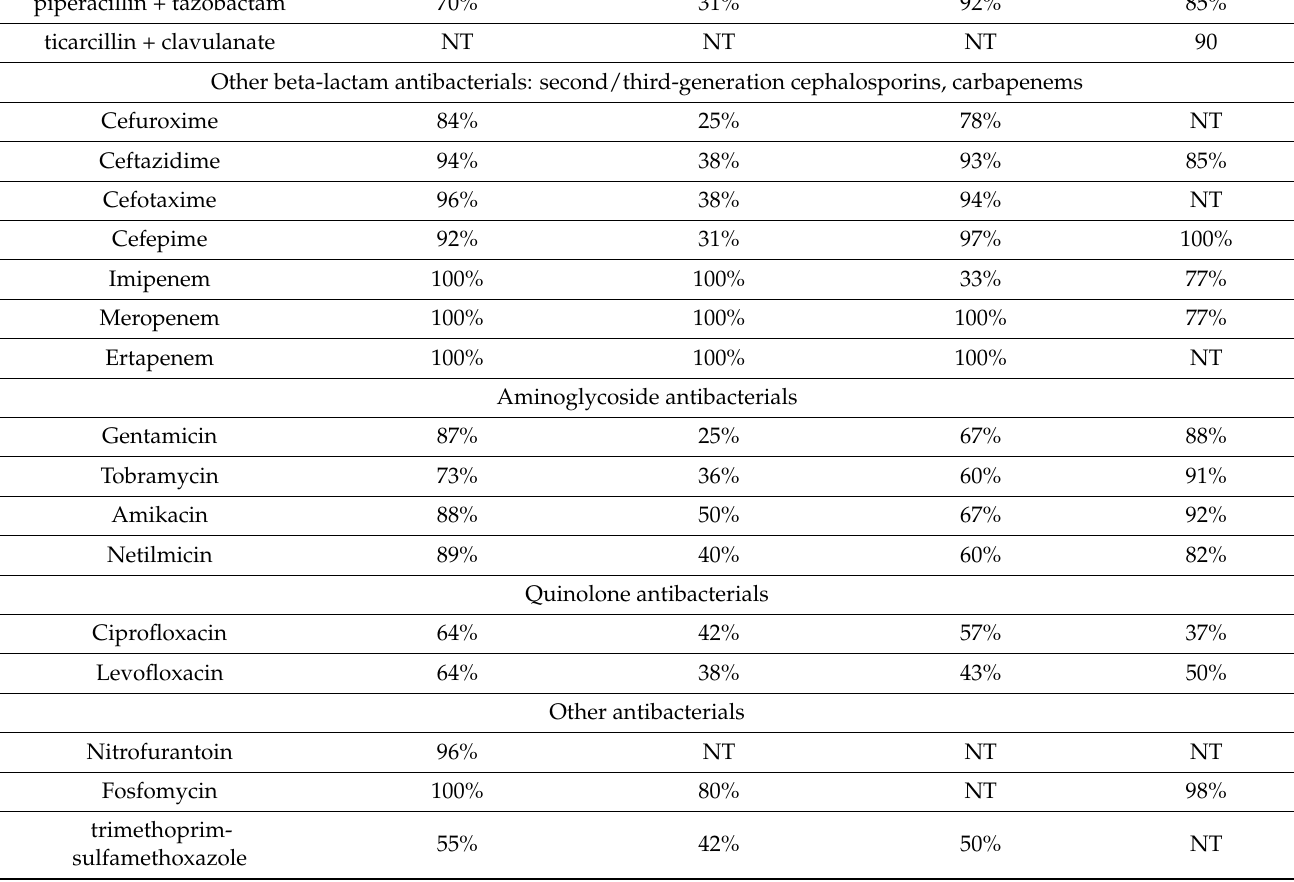
n —total isolates, NT: not